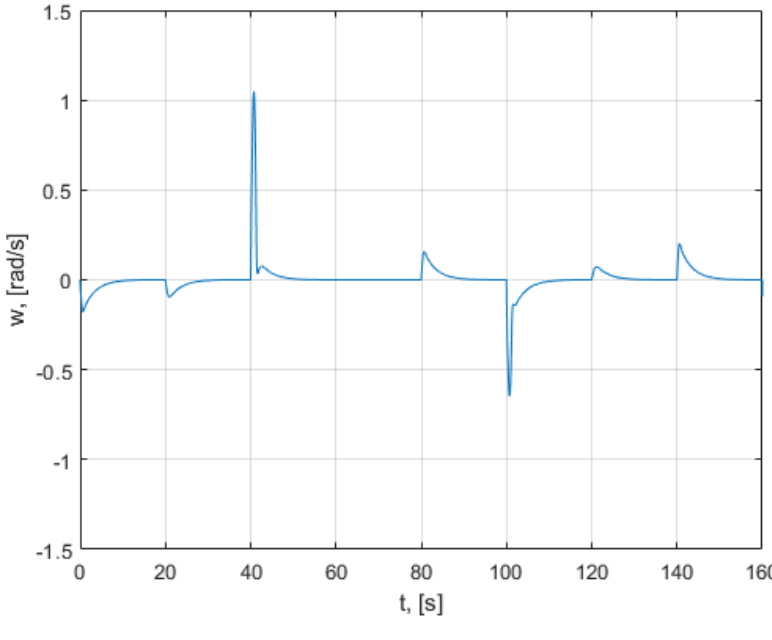
Figure 29. Command torque characteristic.